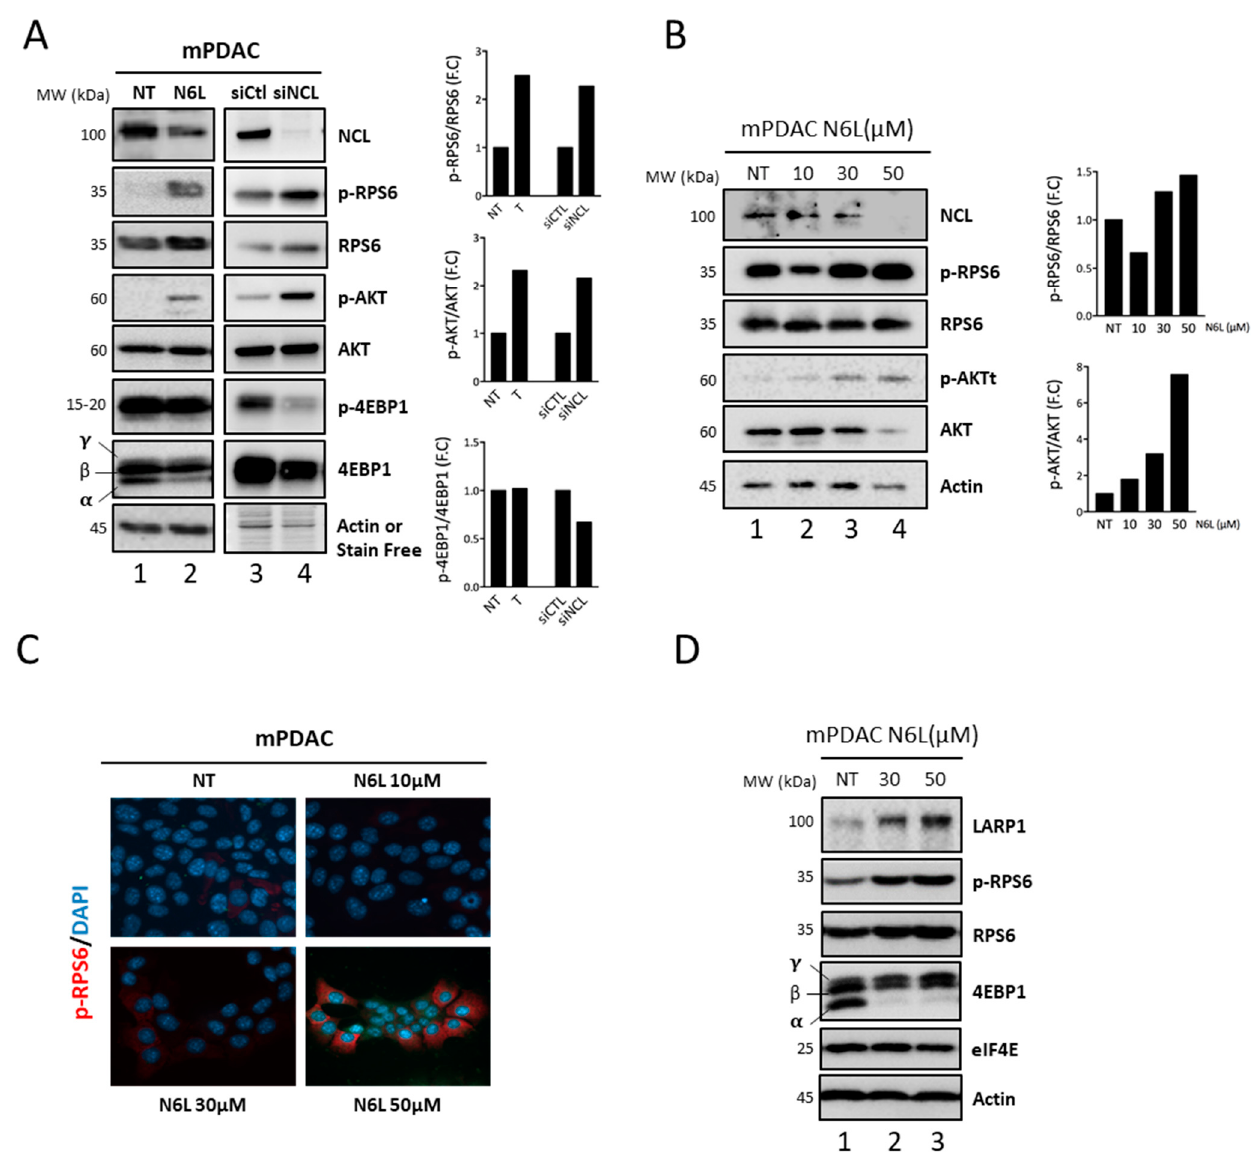
Figure 5. NCL targeting by N6L increases 5’TOP mRNA translation by activating mTOR pathways. ( A ) mTOR pathway activation was analyzed using Western blotting in mPDAC cells, non-treated (NT) or treated with N6L at 50 µ M for 48 h (lanes 1,2) or after NCL siRNA depletion (lanes 3,4). γ and β represent hyper- and α hypo-phosphorylated forms of 4EBP1. The phosphorylated-to-total protein ratio was quantified for RPS6, AKT, and 4EBP1. ( B , C )—mTOR pathway activation was analyzed in mPDAC, non-treated (NT), or treated (T) with N6L at increasing doses using Western blotting ( B ) and immunofluorescence staining ( C ) by anti-phosphorylated RPS6 (red) and DAPI for nuclei (blue). ( D )—Western-blotting analysis of LARP1, RPS6, 4EBP1, and EiF4E expression in mPDAC treated or not with N6L at 30 and 50 µ M for 48